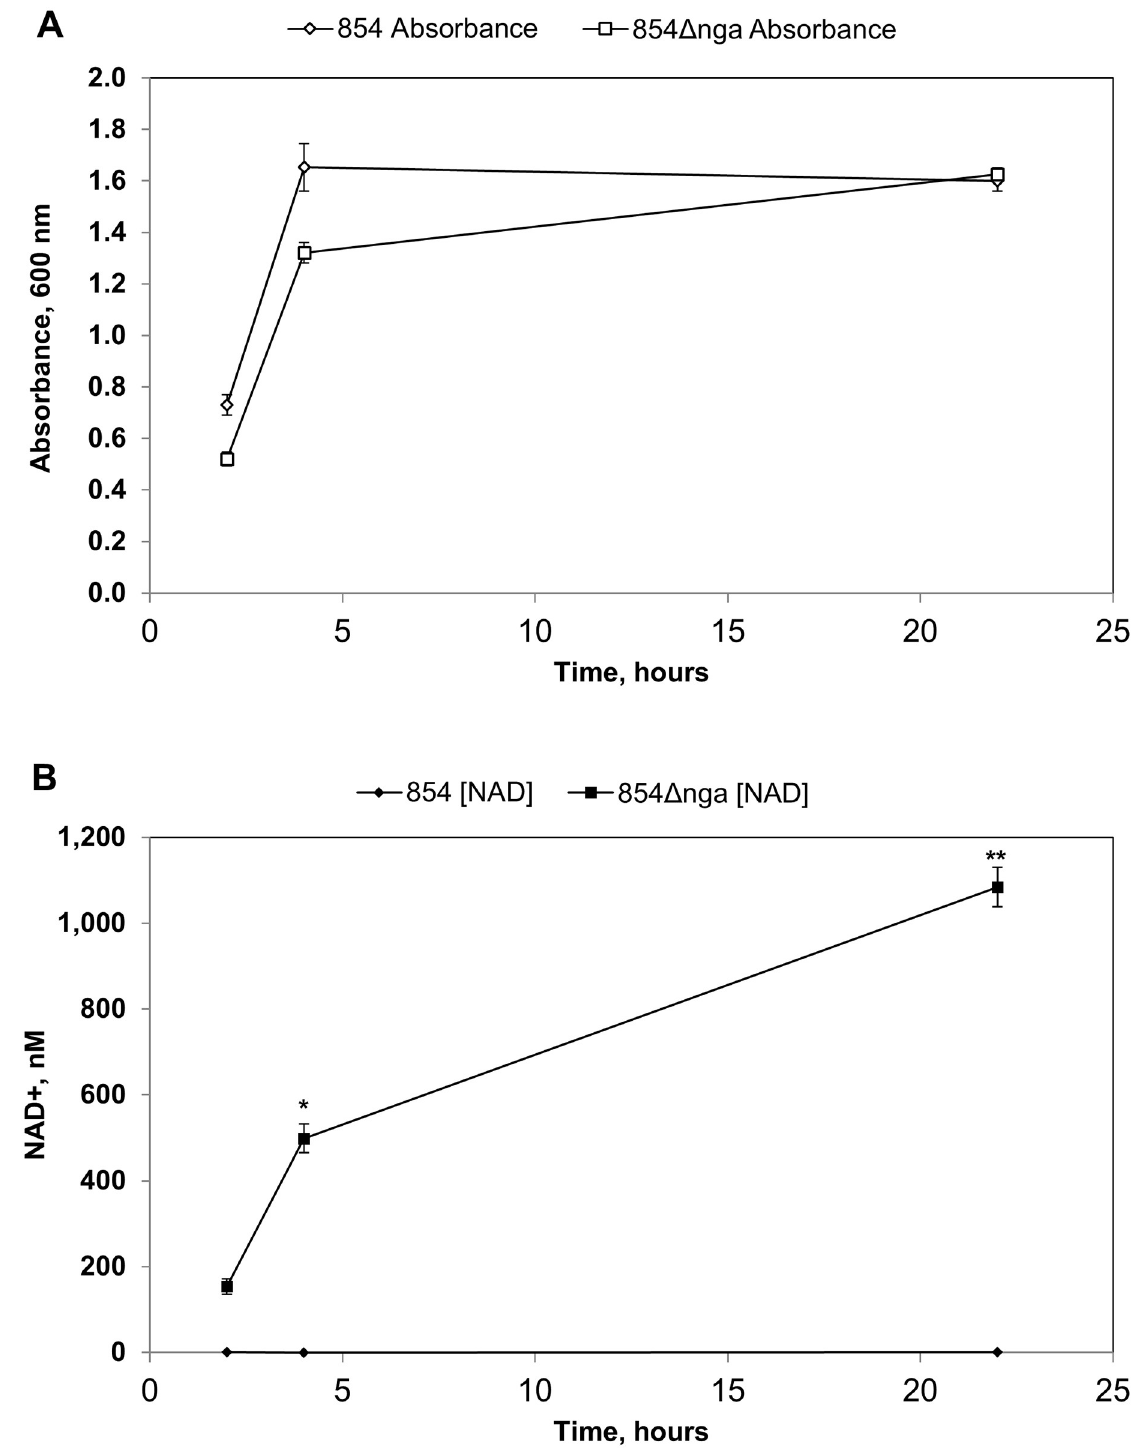
Fig 2. NAD + is released into the growth medium by NADase-negative GAS strains. A . Growth curve of wild type GAS 854 and NADase- deficient 854 Δ nga . B . Measurement of NAD + concentration in the culture supernatant during growth of wild type GAS 854 and NADase- deficient 854 Δ nga . Data are the mean of three biological replicates ± standard deviation. � P < 0.05; �� P < 0.01.